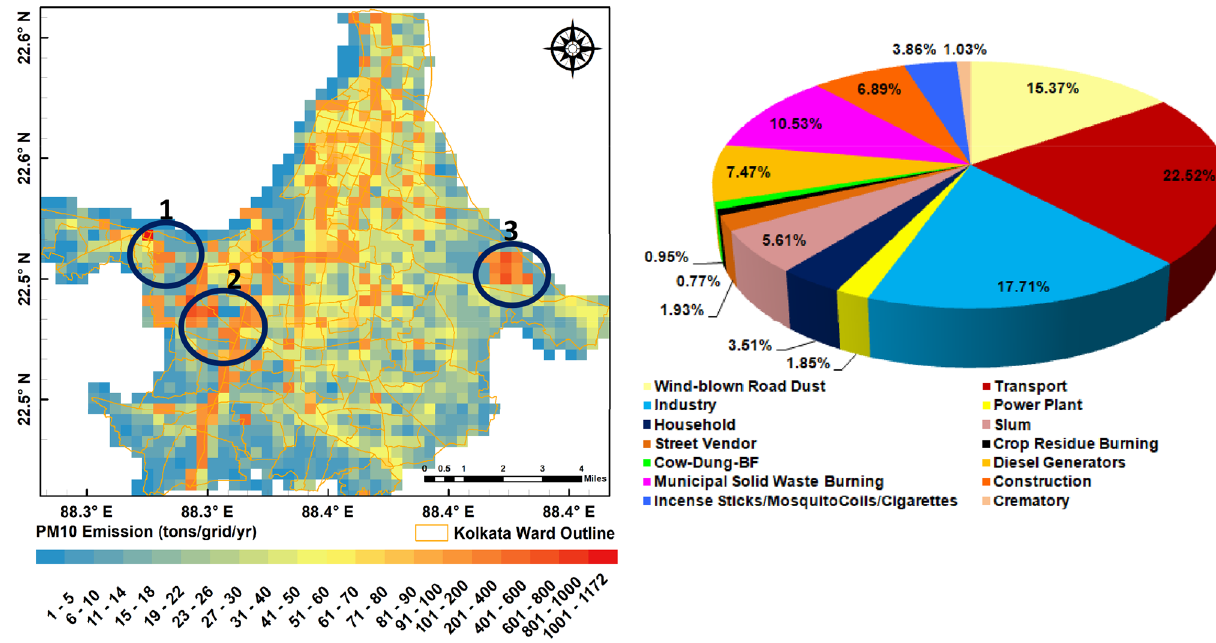
Fig. 3 Gridded annual PM